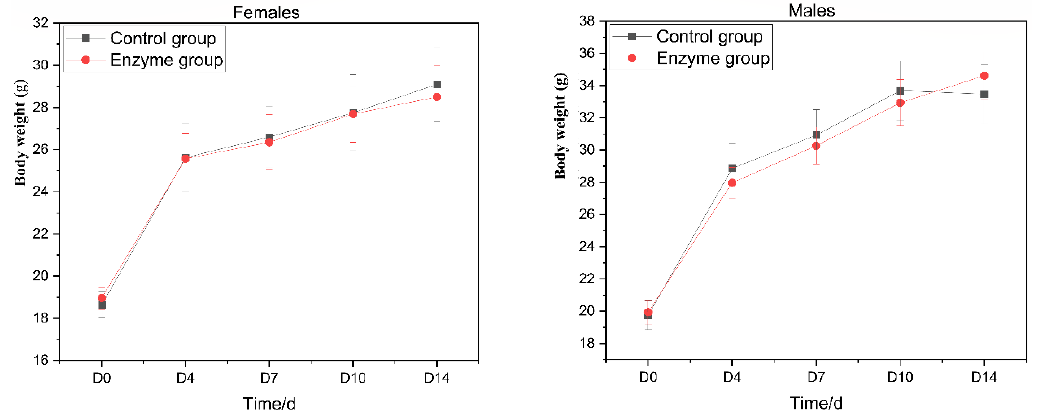
Figure 2. Effect of enzyme solution on body weight of mice.